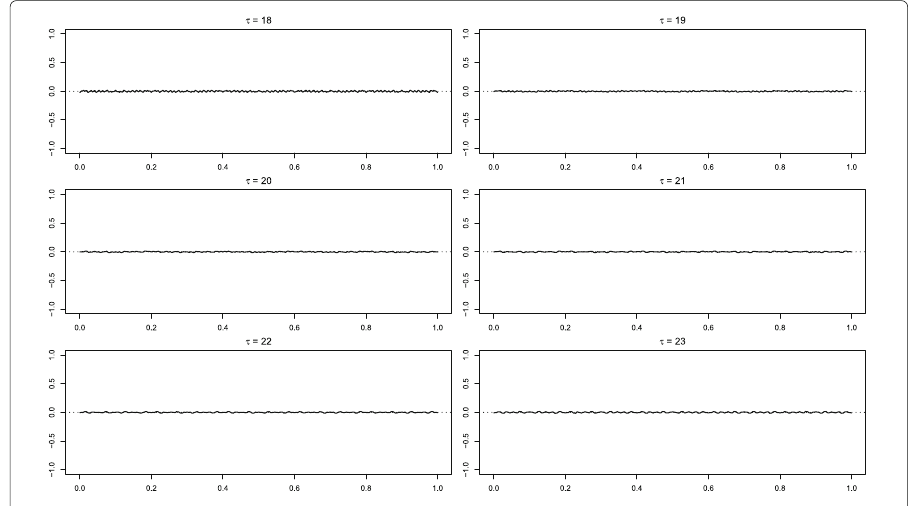
Fig. 26 Differences of true component cos ( 90 π t ) and decomposed high-frequency component of test signal X t = cos ( 90 π t ) + cos ( 10 π t ) according to size parameter